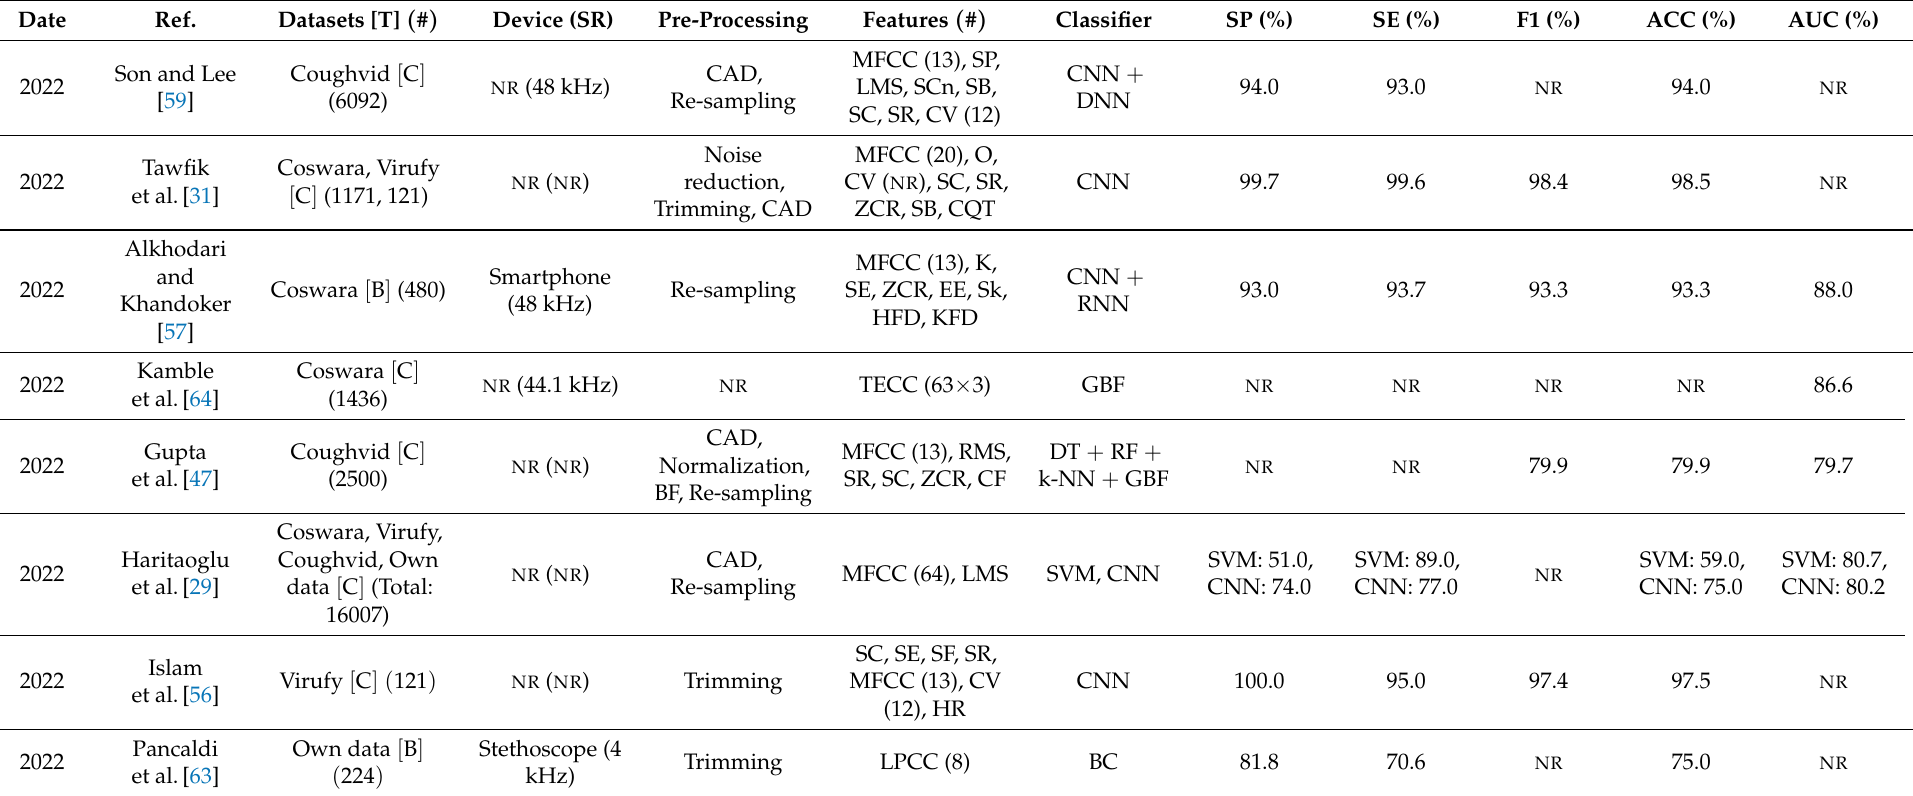
Table 1. Summary of the reviewed papers. Non-reported data are given as “ NR ”. Datasets : T = type of collected data (B: breath, C: cough, V: voice), # = number of selected samples. Pre-processing : CAD = Cough Activity Detection. Features : Extracted features (number of features, only reported if the given feature is not a one-element category); numbers of features given as ( x × 3 ) indicate the use of the fundamental coefficients together with the corresponding ∆ and ∆ 2 values. Classifier : employed classification algorithm. Metrics : Specificity (SP), Sensitivity (SE), F-score (F1), Accuracy (ACC), and Area Under the Curve (AUC), given in